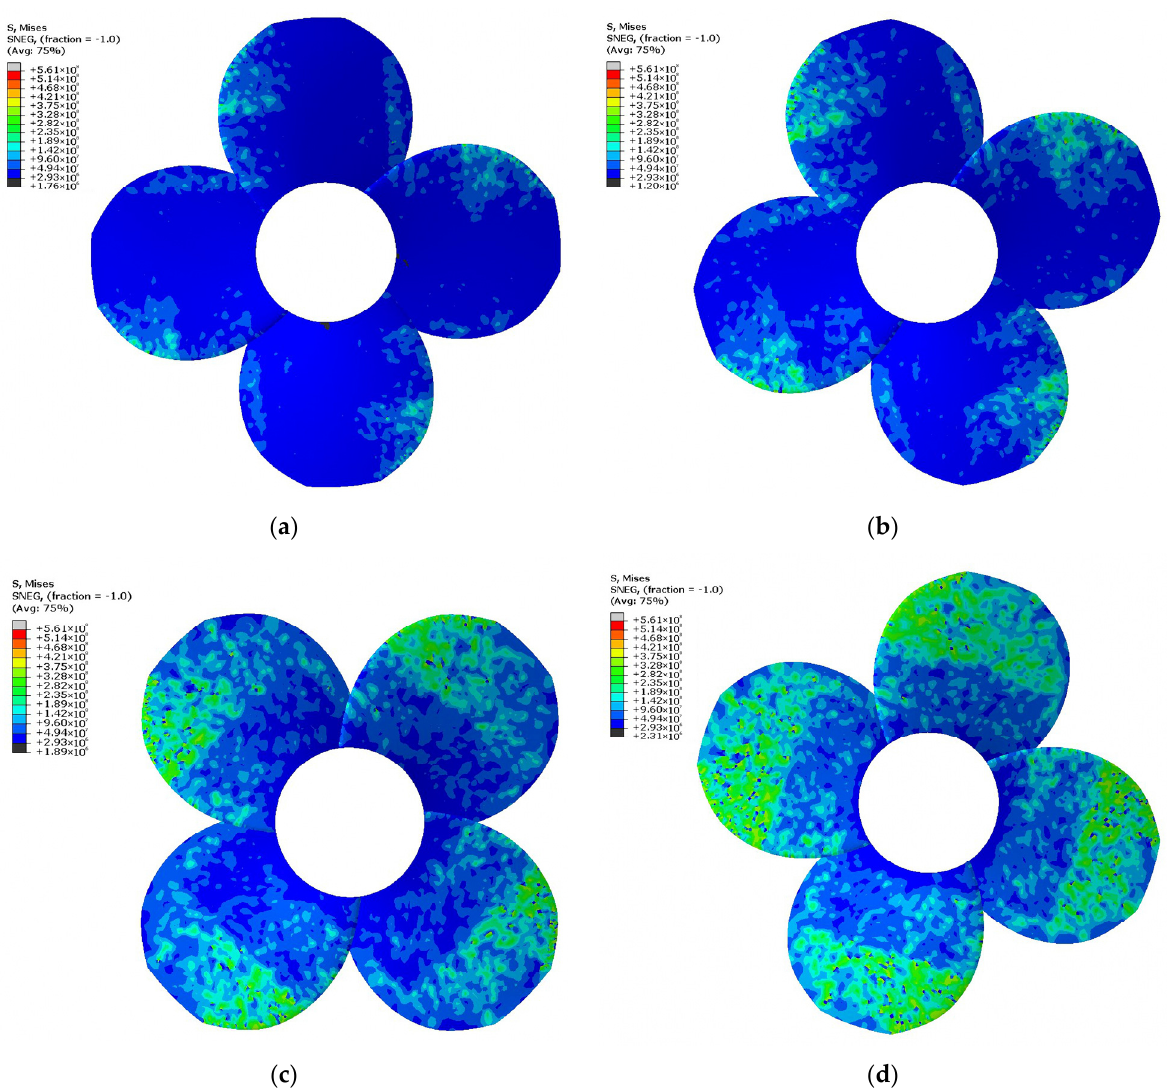
Figure 11. Stress distribution during propeller and ice cutting. ( a ) Stress distribution during 0.035 s propeller and ice cutting; ( b ) stress distribution during 0.04 s propeller and ice cutting; ( c ) stress distribution during 0.05 s propeller and ice cutting; ( d ) stress distribution during 0.06 s propeller and ice cutting.